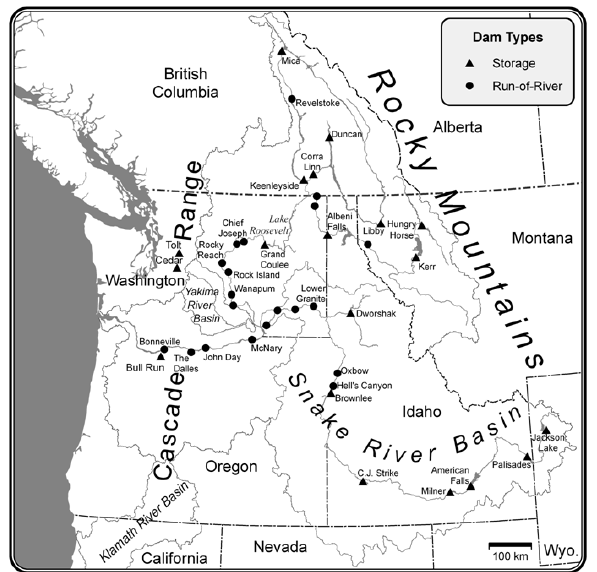
Figure 1. Map of the Pacific Northwest including the Columbia River basin and Coastal Drainages in WA and OR. Major dams in the Columbia and selected projects and geographic features discussed in the text are shown.